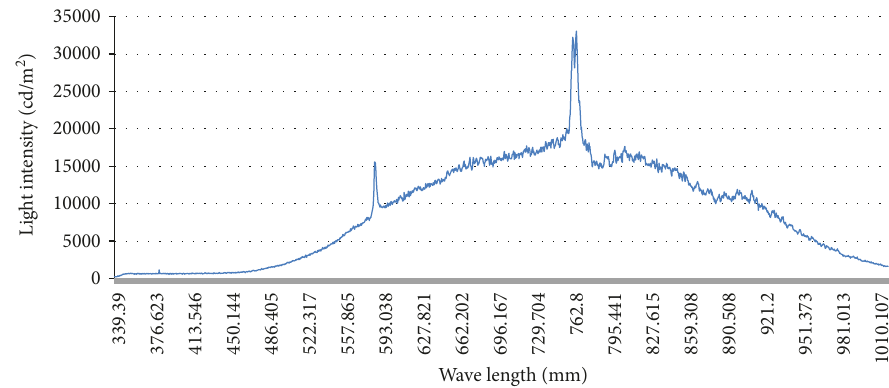
Figure 6: June 22, 2017, 18:37:00 converter 6C00582 light intensity-optical frequency